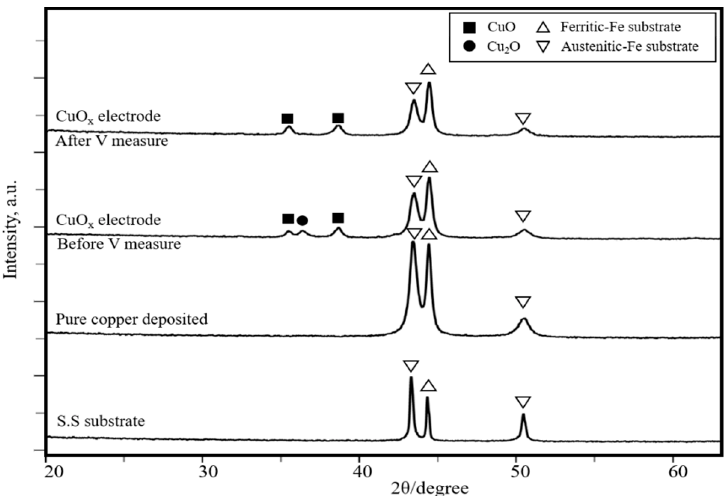
Figure 3. XRD patterns of stainless steel substrate, pure Cu-deposited substrate, Cu oxides electrode before photopotential measurement, and Cu oxides electrode after photopotential measurement.